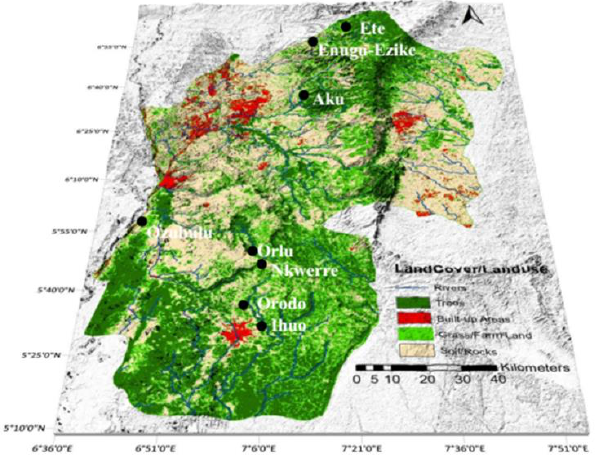
Figure 5: Landuse/landcover Map of the Study Area.